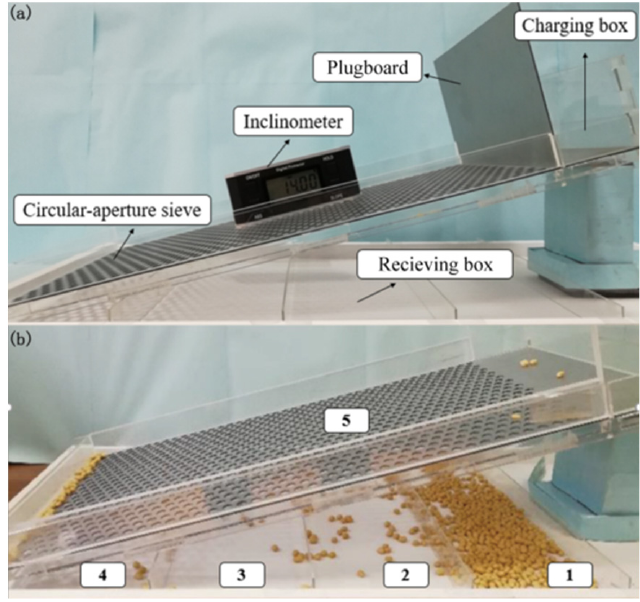
Figure 6. ( a ) Device of the “self-flow screening” and ( b ) the statistical areas of the device.